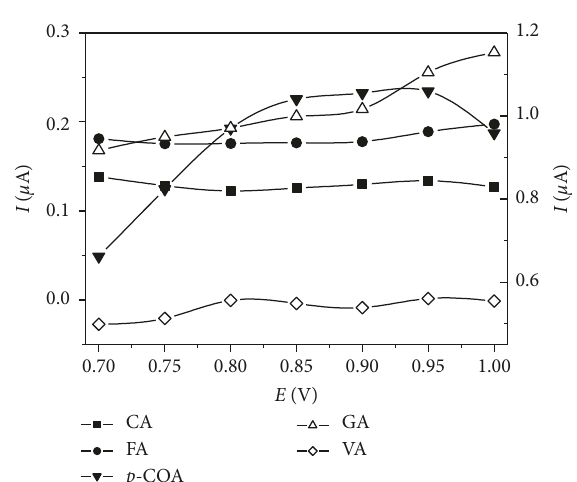
Figure 5: Plot of applied potential versus peak current for all analytes. Left axis (black symbols): CA: caffeic acid (3.60 mg 1 ). Right axis (white symbols): GA: gallic acid